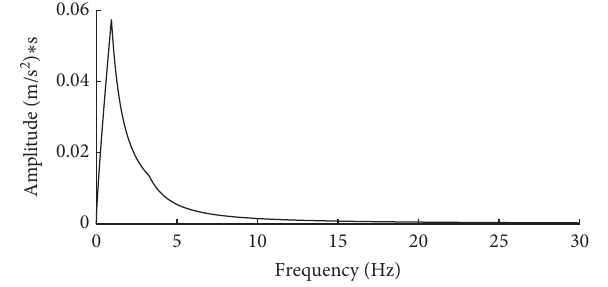
Figure 8: Power spectrum of artificial